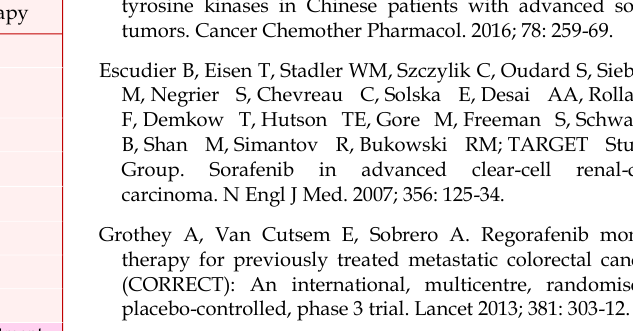
n=30 in each group; No Grade 5 treatment-related treatment- emergent adverse event occurred at an overall rate